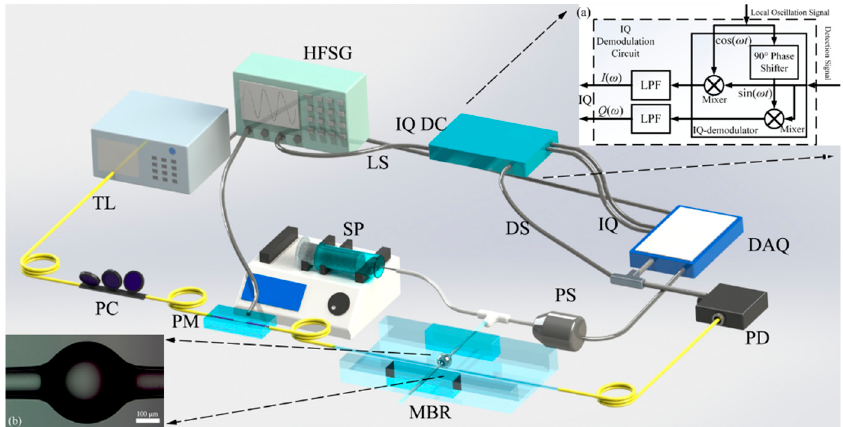
Figure 1. Setup schematic of the orthogonal demodulated Pound–Drever–Hall technique system. TL, tunable laser; PC, polarization controller; PM, phase electro-optical modulator; MBR, micro-bubble resonator; PD, photoelectric detector; DAQ, data acquisition card; IQ, I-term and Q-term signal; HFSG, high frequency function signal generator; PS, pressure sensor; SP, syringe pump; DS, detection signal; LS, local oscillation signal. IQ DC, IQ demodulation circuit. The inset ( a ) illustrates the IQ demodulation circuit detail. The inset ( b ) provides an image of the